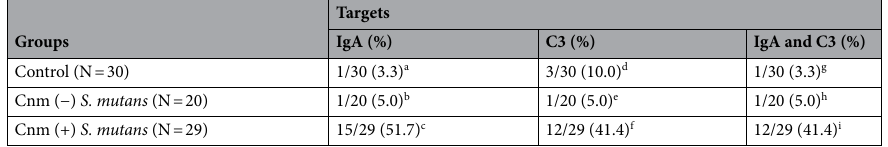
Table 2. Frequencies of positive immunohistochemical staining in rats inoculated with Cnm-positive and Cnm-negative S. mutans . Statistical significance was determined using Fisher’s exact test. ( a,c P < 0.001, b,c P < 0.001, d,f P < 0.01, e,f P < 0.01, g,i P < 0.001, and h,i P <